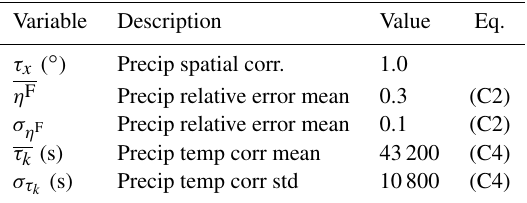
Table C1. Constant values used to perturb the precipitation fields. k is the assimilation